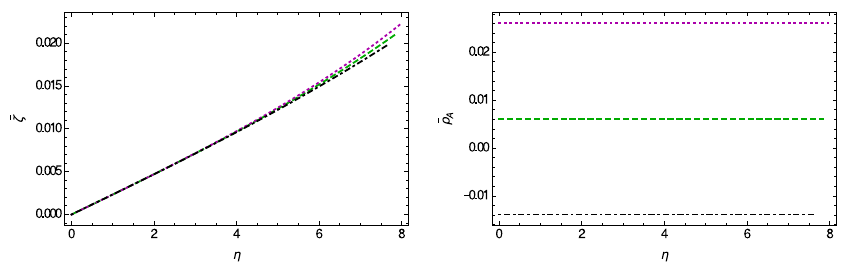
Fig. 16 Variation of ¯ ζ (left panel) and ¯ ρ A (right panel) as a function of η in three-form field quark stars, for three different values of the con- stant ¯ λ : ¯ λ = 0 (dashed curve), ¯ λ = 0 . 02 (dotted curve), and ¯ λ = − 0 . 02